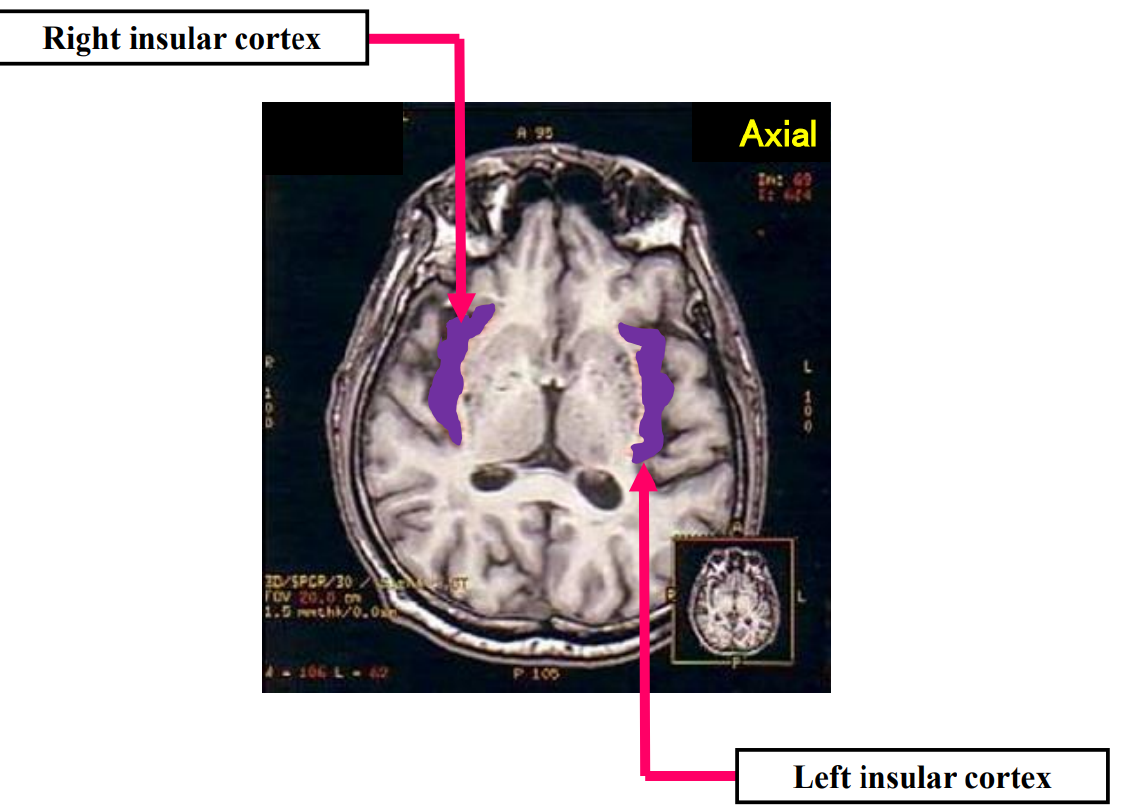
Figure 1. Axial T1-weighted MRI. White matter of the orbitofrontal cortex continues to the extreme capsule deep to the anterior insular cortex. Reconstructed from [4]. capsule deep to the anterior insular cortex. Reconstructed from